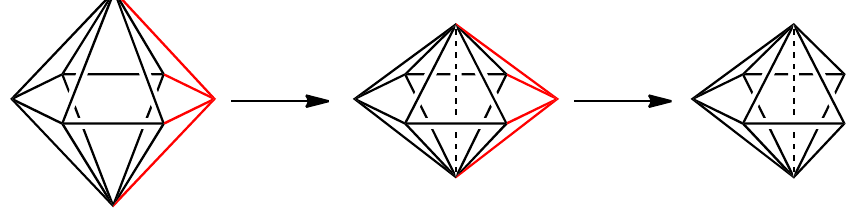
Figure 3. Generation of the oblatonido-deltahedral cage of M 2 B 5 clusters 1 – 8.